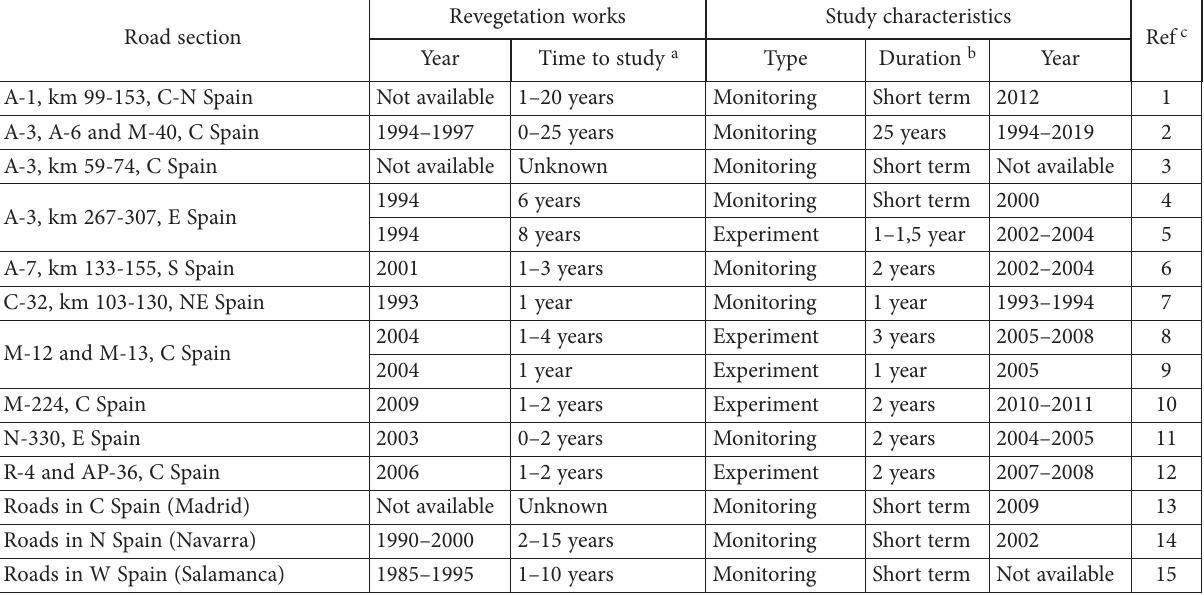
Table 1. Studies about road slope revegetation in Spain Road